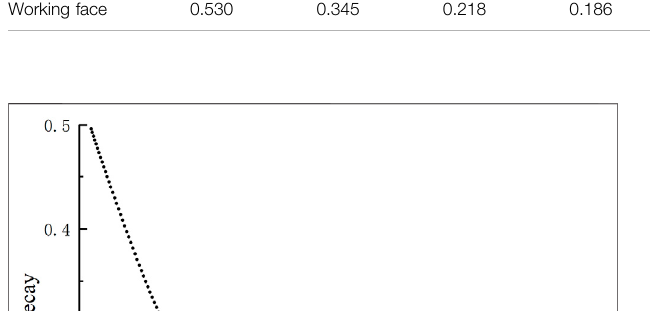
Frontiers in Energy Research |